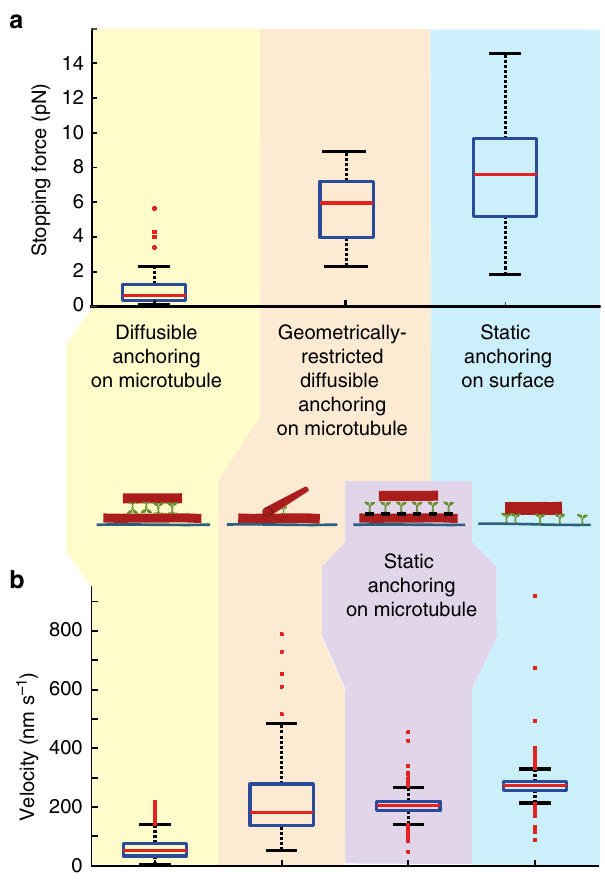
Fig. 4 Comparison of the different geometries. a Comparison of stopping forces for the cases of diffusively anchored fl Ncd ( N = 33 microtubules), fl Ncd with geometrically restricted diffusible anchoring (between non- aligned microtubules, N = 8) and Ncd Δ tail statically anchored on a surface ( N = 78). Several values above 14 pN lie outside of the depicted range for the case of surface-immobilized motor domains. b Comparison of microtubule transport velocities when propelled by diffusively anchored fl Ncd ( N = 265), fl Ncd with geometrically restricted diffusible anchoring (between non-aligned microtubules, N = 83), Ncd Δ tail statically anchored on microtubules ( N = 200) and Ncd Δ tail statically anchored on a surface ( N = 879). Two values lie outside of the depicted range for the cases of geometrically hindered diffusion and one value for the case of surface- immobilized motor domains. For the boxplot elements description